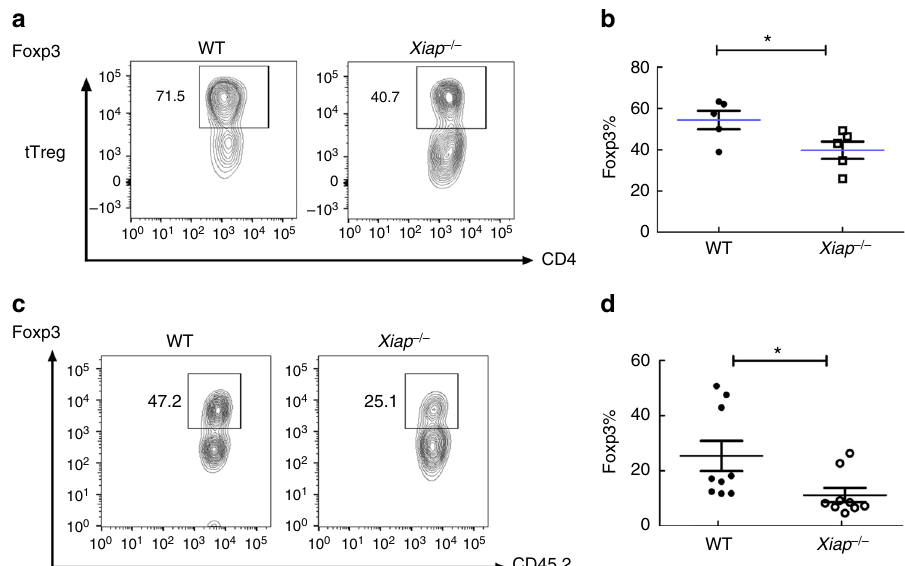
Fig. 2 Foxp3 instability in activated Xiap − / − Treg cells. a , b Reduced Foxp3 + population in activated Xiap − / − tTreg cells. WT and Xiap − / − tTreg cells were stimulated with anti-CD3/CD28 in the presence of IL-2 for 4 days. Foxp3 expression of activated tTreg cells was determined by intracellular staining and analyzed by fl ow cytometry. The gated section represents the Foxp3 + population and the number indicates the percentage of each population ( a ). The Foxp3 + fractions in WT and Xiap − / − tTreg cells were quantitated ( b ), n = 5. c , d Diminished Foxp3 high population in adoptively transferred Xiap − / − tTreg cells. CD45.2 + tTreg cells were recovered from CD45.1 + Rag1 − / − mice into which CD45.2 + tTreg cells and CD45.1 + CD4 + CD25 − T cells had been transferred a month earlier. The isolated CD45.2 + CD4 + T cells were reactivated with TPA/A23187 and Foxp3 expression was determined by intracellular staining ( c ). The Foxp3 + fractions in the transferred WT and Xiap − / − tTreg cells re-isolated from Rag1 − / − mice were quantitated ( d ), n = 9. * P < 0.05